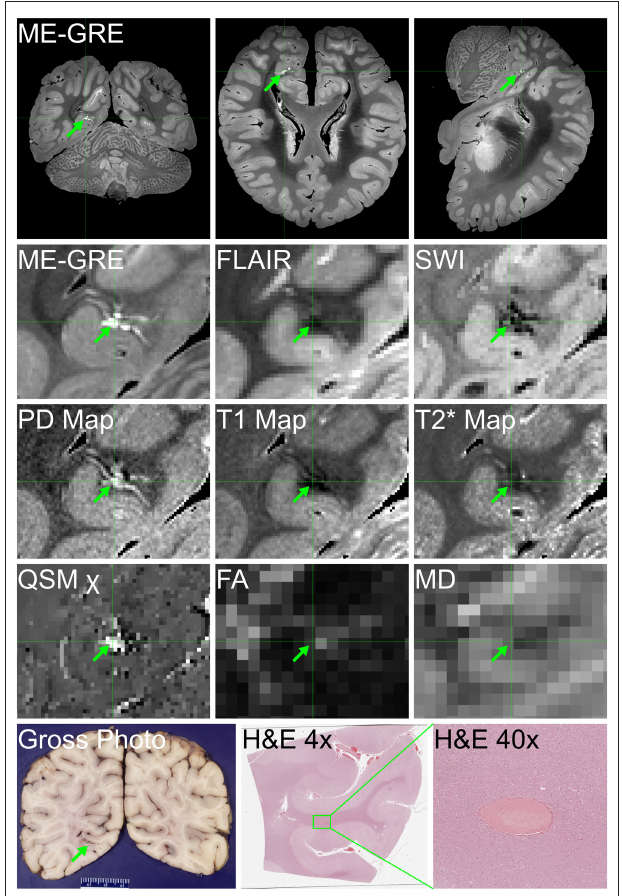
FIGURE 6 | Ex vivo MRI and autopsy neuropathology in Case 7. (Top) Three-plane multi-echo gradient-echo MR images, displayed in radiological orientation convention, showing the location of the imaging-identified finding in the pons. (Middle) The appearance of the finding of interest on multiple image contrasts and parametric maps, displayed in radiological orientation convention maps. (Bottom) Gross photograph of pons with corresponding blood vessel; Luxol fast blue H&E (LHE) histology of same vessel, which at higher magnification has perivascular rarefaction, proteinaceous material and lymphocytes (ocular magnificaitons 2 × , 10 × , and 60 × ,